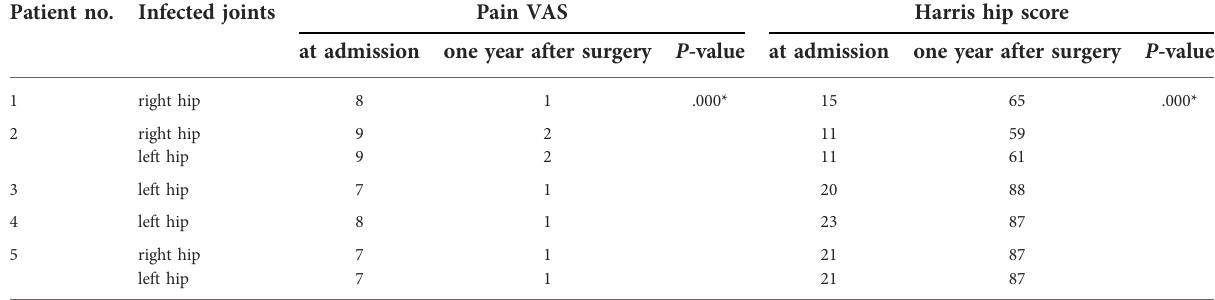
TABLE 2 Summary and comparison of the VAS pain score and Harris hip score of 5 patients at admission and one year after surgery. Patient no. Infected